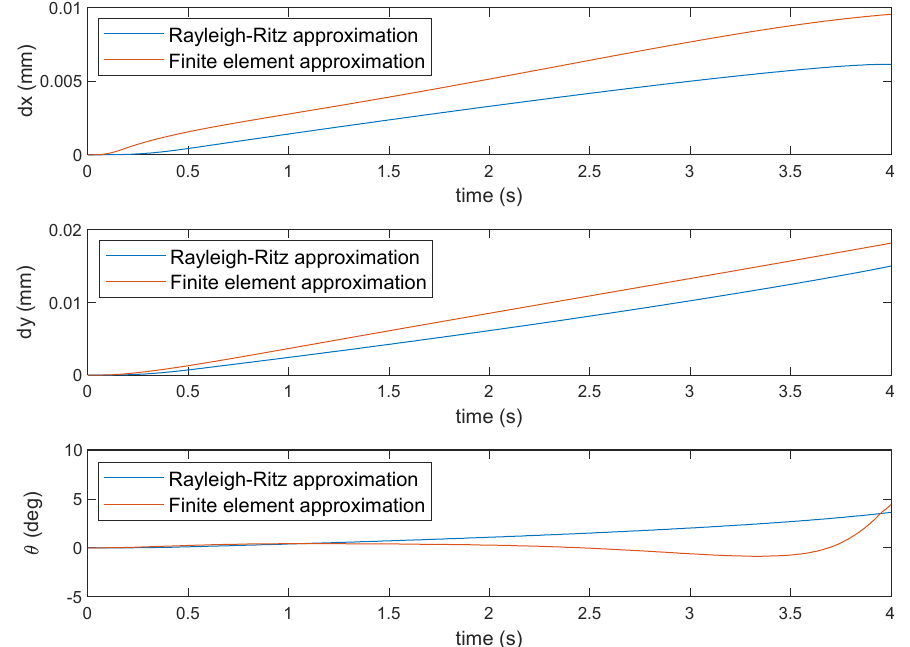
Figure 11. The elastic displacements and the orientation of the end-effector obtained by using the two methods in the case of triangular pulse loads.